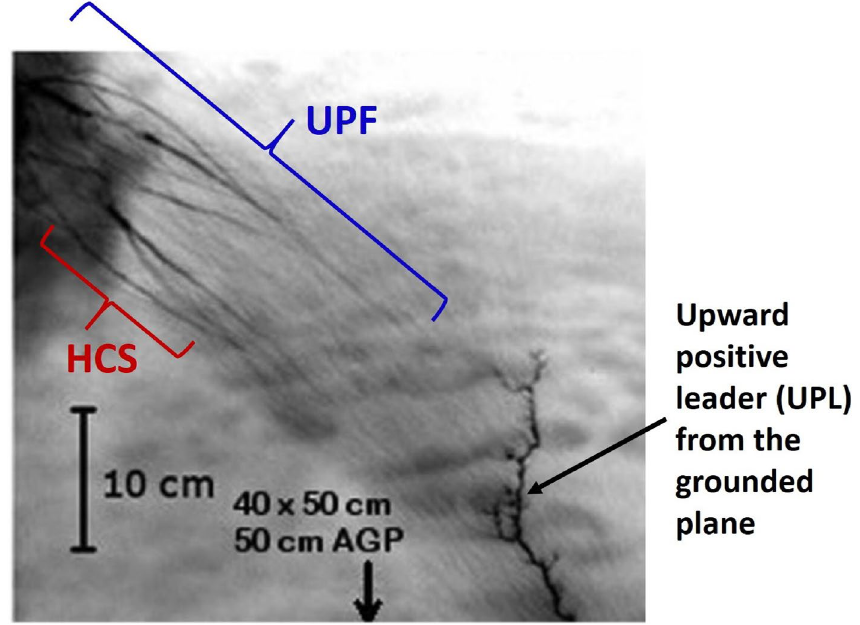
Figure 2. Infrared image (negative) that shows an unusual plasma formation (UPF) with embedded hot channel segments (HCS) inside the cloud of small water droplets. Also seen in this image is an upward positive leader (UPL) from the grounded plane, whose channel is expected to be hot. Note that HCS and UPL have about the same infrared brightness and, hence, about the same temperature. The entire region shown is inside the cloud. Exposure time was 6.7 ms. AGP = above the grounded plane. Adapted from [ 8 , Fig. 5b].